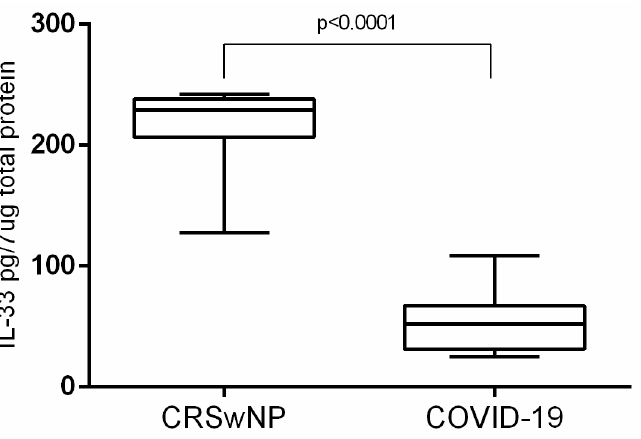
Figure 9. Tissue IL-33 concentration in the nasal mucosa (CRSwNP and COVID-19 ).